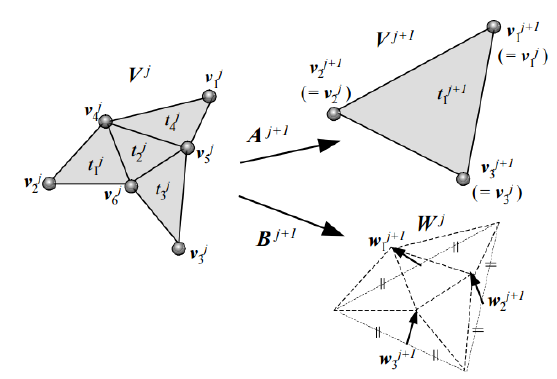
Figure 2. Illustration of the lazy wavelet mechanism applied to a triangular semiregular mesh [18].